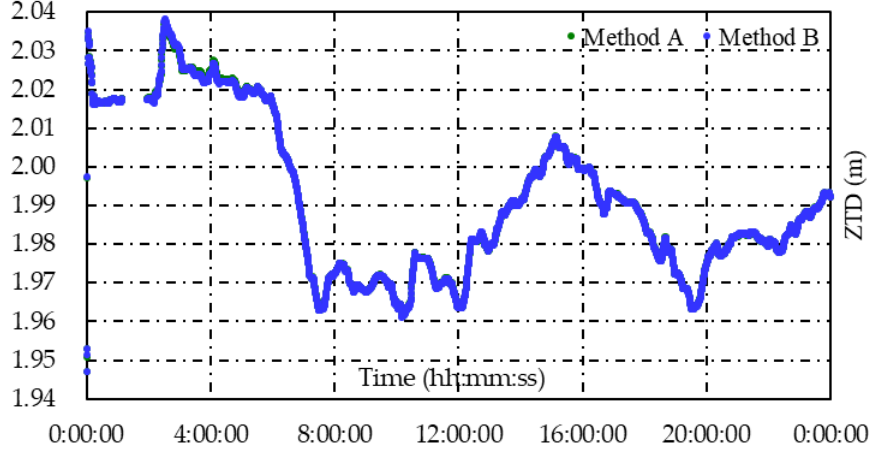
Figure 12. ZTDs from kinematic PPP with methods A and B.